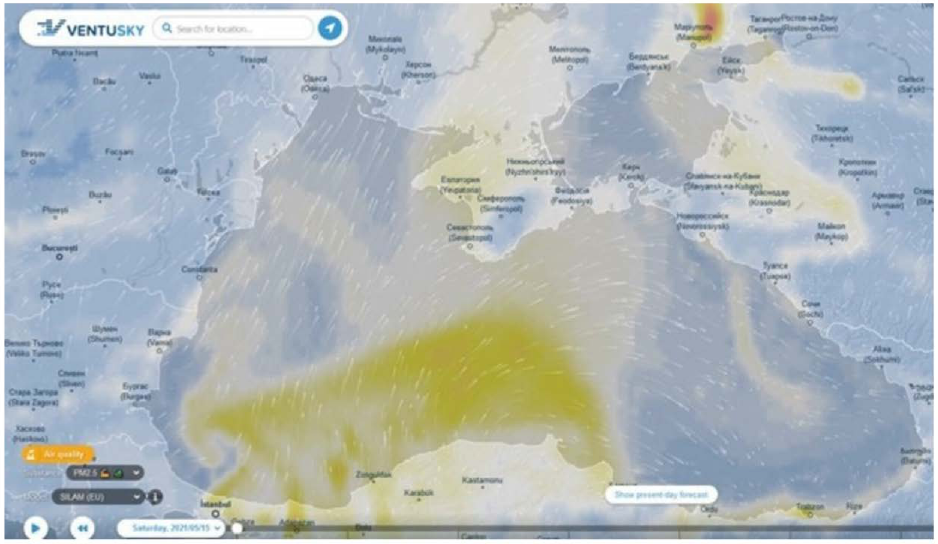
Figure 6. Air pollution by PM 2.5 on 15 May 2021 according to the website